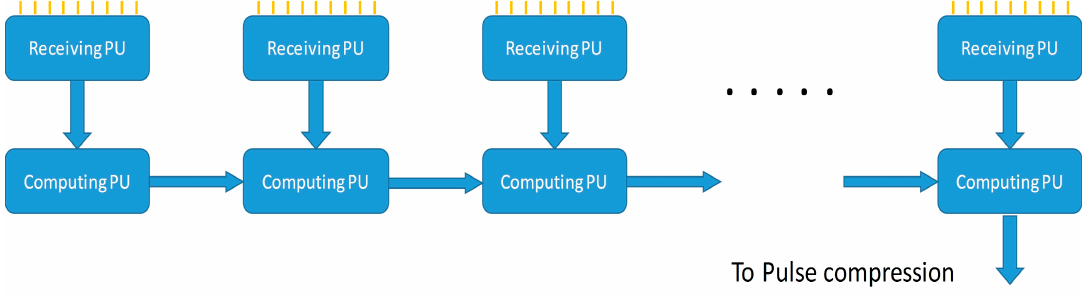
Figure 10. Scalable beamformer architecture.